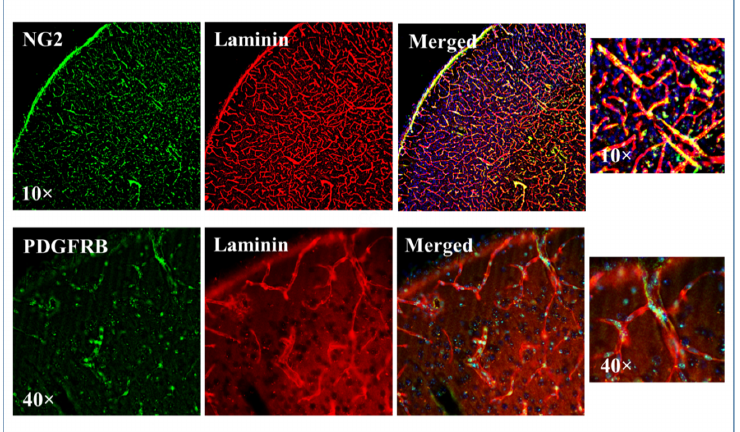
Figure 4. Pericyte staining in 3% glyoxal fixed brain. Pericyte staining of brain coronal plane sections after glyoxal fixation. Pericytes in brain sections were detected by common pericyte markers, NG2 and PDGFRB and laminin was used for vascular staining.